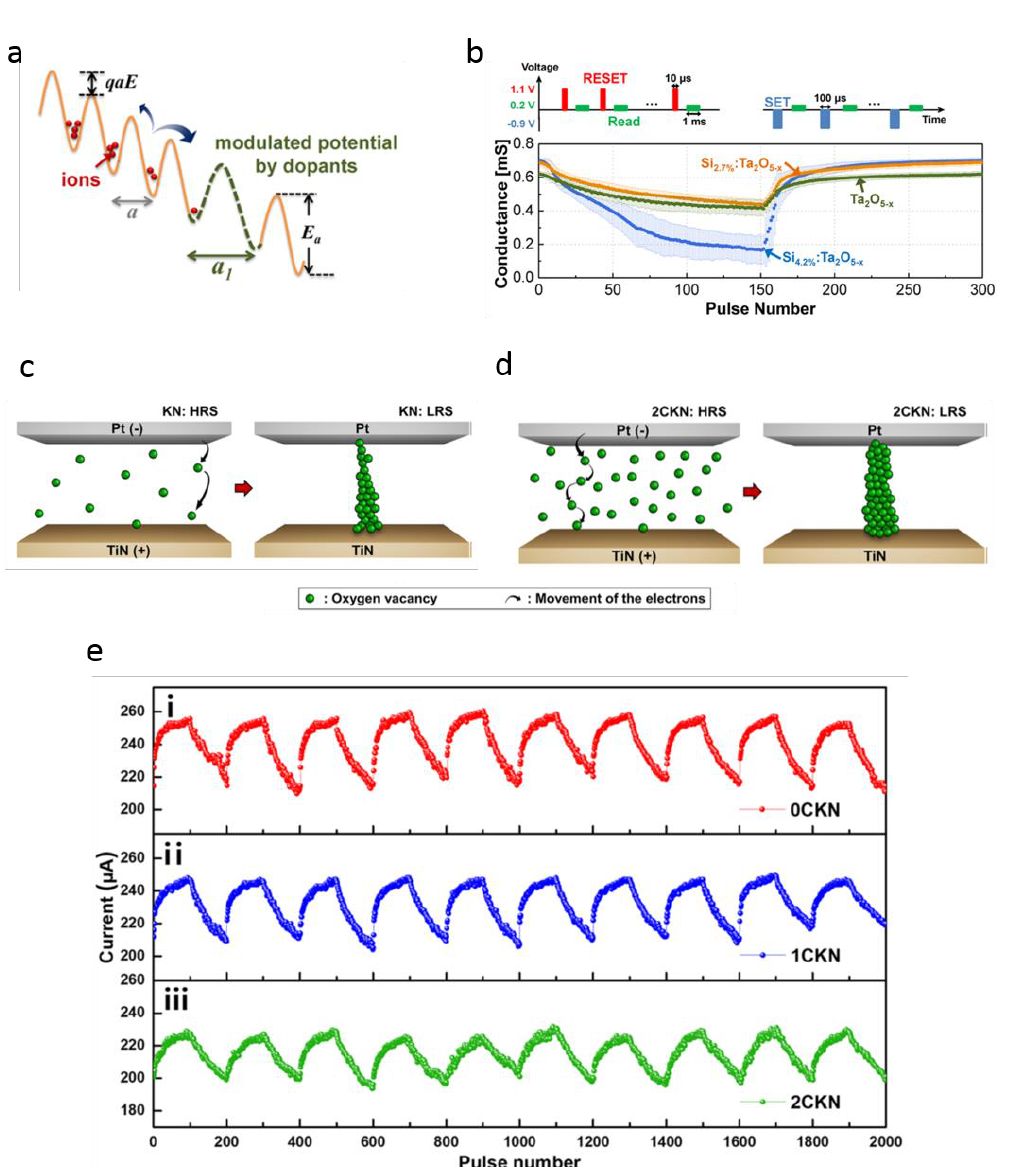
doping. Figure 7b exhibits the measured analog switching behaviors of Ta 2 O 5-x layers with different Si doping concentrations under pulse trains. It can be clearly observed that the dynamic range increases with the doping concentration of Si. Furthermore, an increased Si doping level results in a higher dynamic range but more digital-like switching, due to the larger hopping distance.